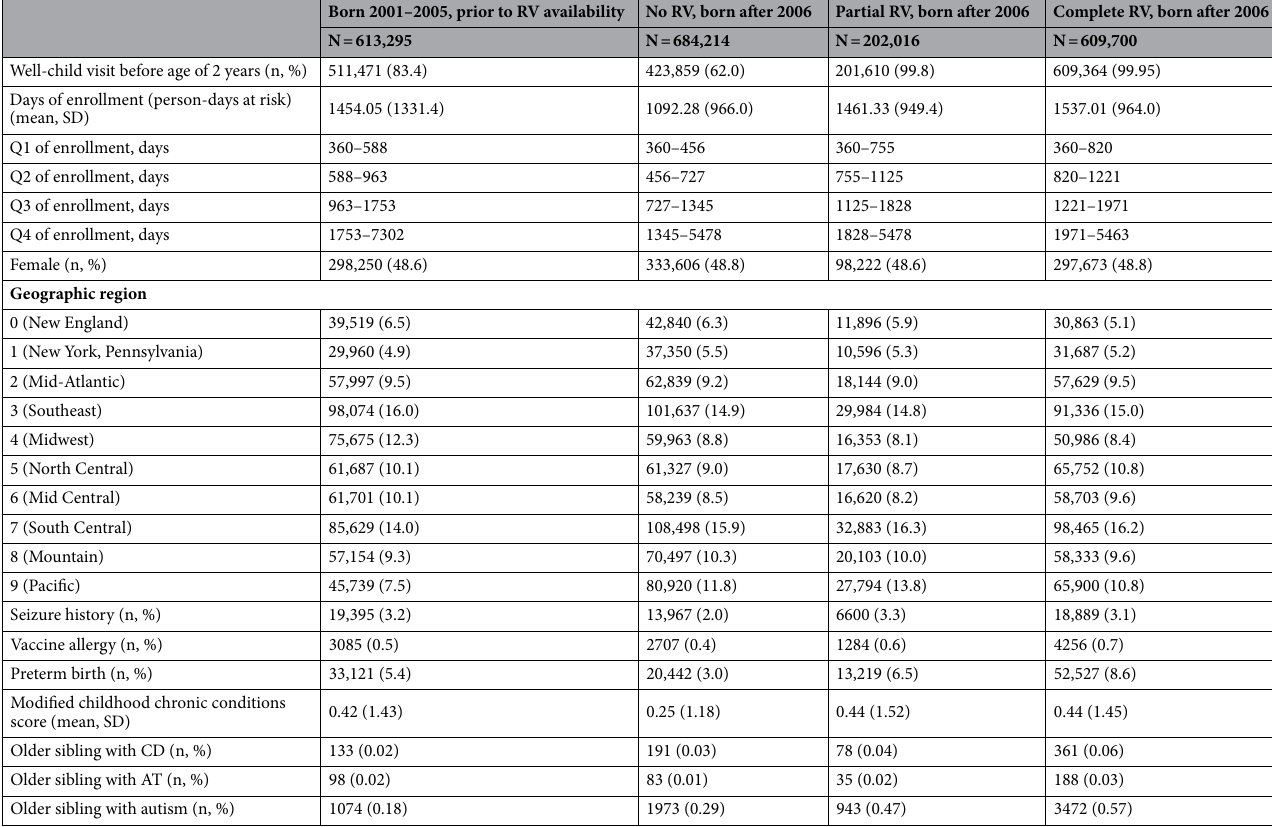
Table 1. Characteristics by rotavirus vaccination (RV) status (n = 2,109,225). N (%) or mean (SD) shown.